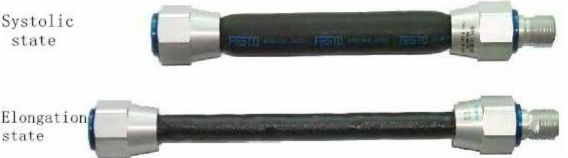
Figure 10. The pneumatic artificial muscle produced by FESTO